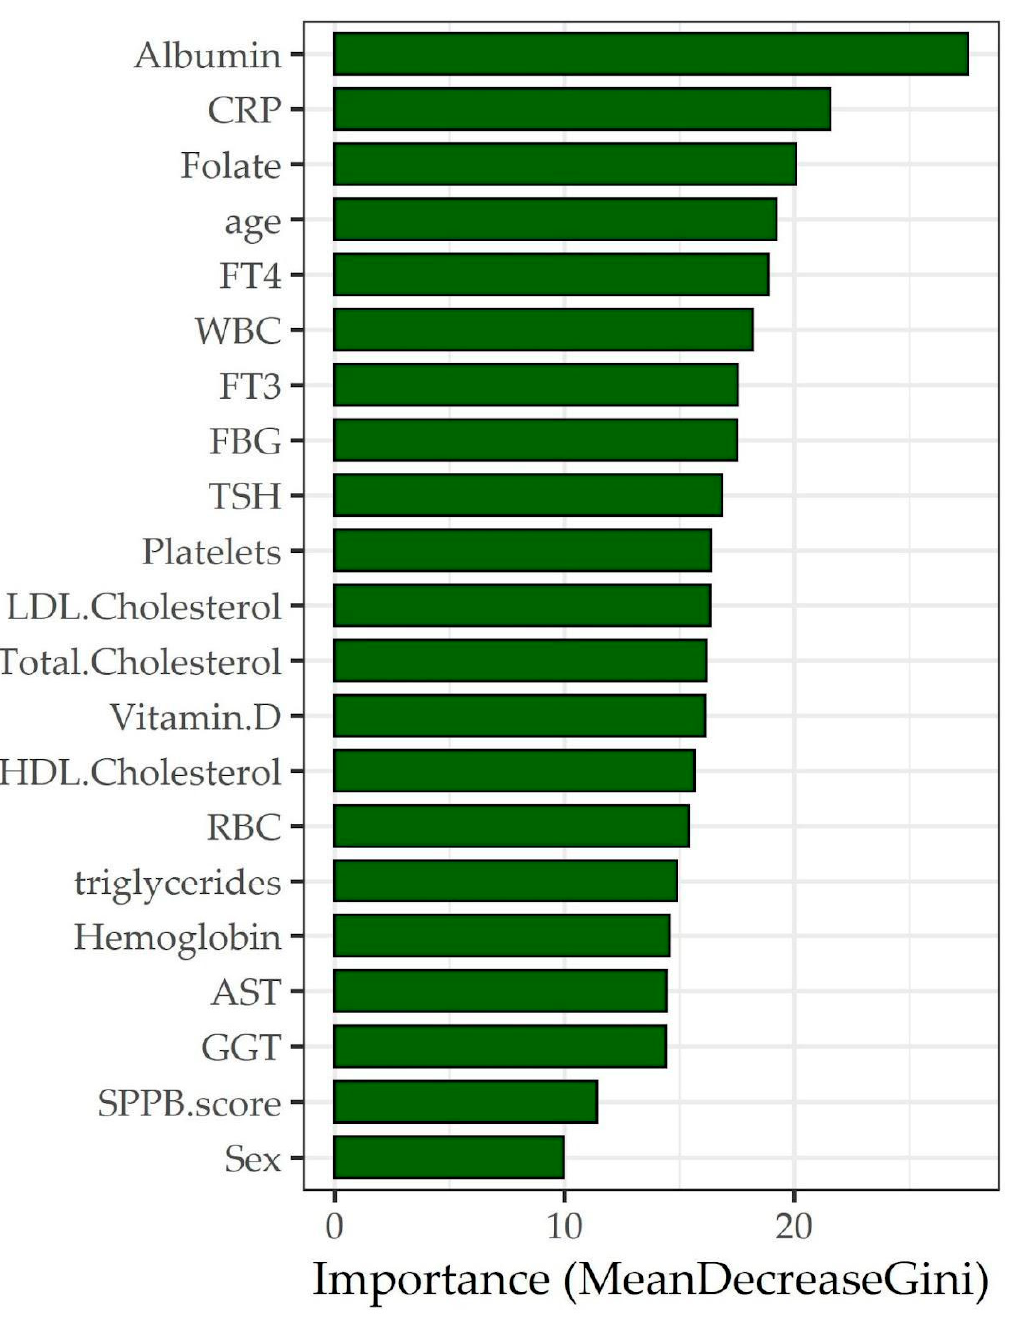
Figure 2. Variable-importance plot for the random forest regression model with sarcopenia status as the dependent variable and socio-demographic and haematochemical variables as regressors. Table 3. Confusion matrix (Salus dataset as test dataset) on sarcopenia status.